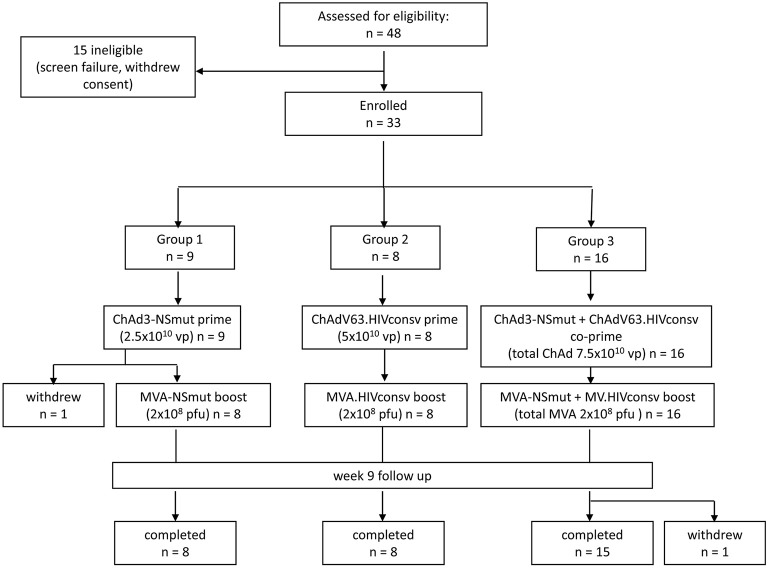
Consort flow diagram showing enrolment and follow-up in the PEACHI 04 trial.